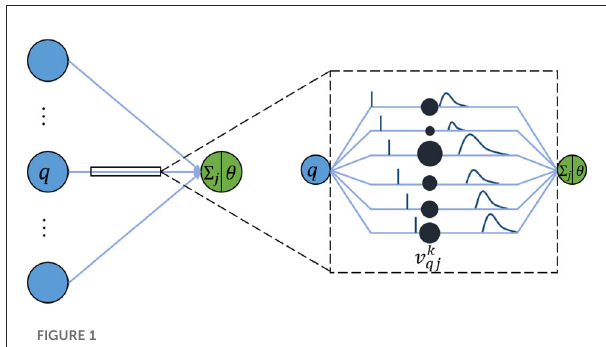
FIGURE1 Schematic diagram of